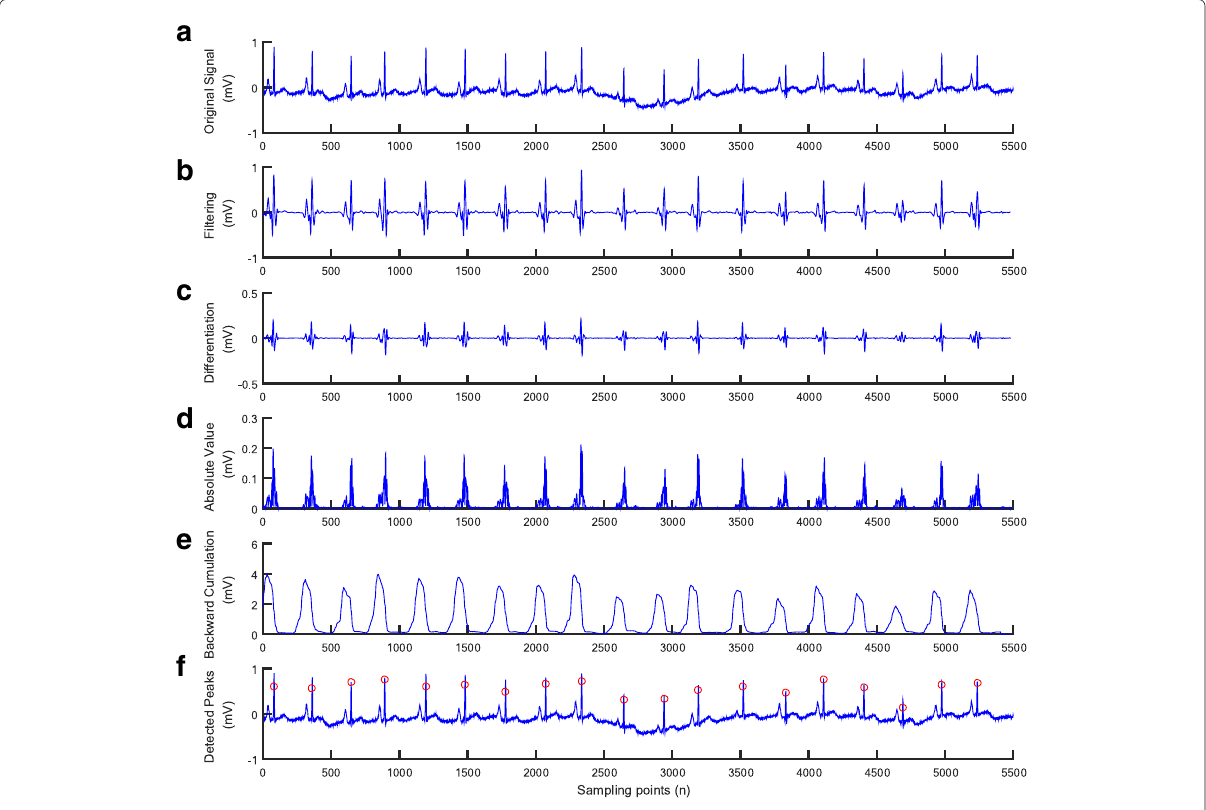
Fig. 7 Results after performing each stage of the method for the ECG with tall P waves (ECG recording 222). a ) Original signal. b ) Filtering. c ) Differentiation. d ) Absolute value. e ) Backward cumulation. f ) Detected peaks